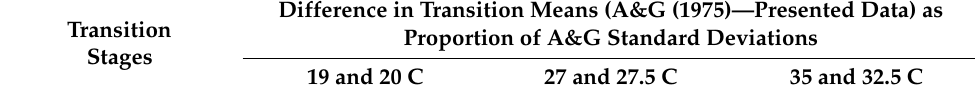
Table 7. Difference in transition means observed here for Lucilia sericata as proportion of Ash and Greenberg [9] standard